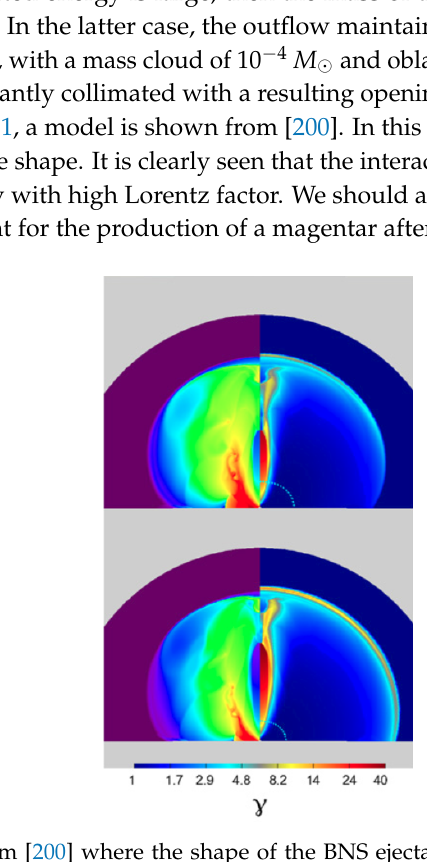
Figure 11. A model from [200] where the shape of the BNS ejecta is assumed to be oblate. In the upper and lower rows, two different times are depicted: ct / R 0 = 15, 25, where R 0 = 850 km is the initial radius of the mass cloud. The initial opening angle of both models is 60 ◦ . The left panel of each plot shows the density and the right panel of each plot shows the Lorentz factor. The outer surface of the expanding mass ejecta is depicted with a dashed cyan curve. The model depicted in this figure with the oblate shaped cloud clearly produces a narrow relativistic outflow. In both cases, the ratio between the energy of the engine to the rest mass energy of the ejecta is E engine / M 0 c 2 = 0.024, where M 0 = 10 − 4 M (cid:12) is the mass of the cloud ejecta. (Reprinted from [200]. c (cid:13) AAS. Reproduced with